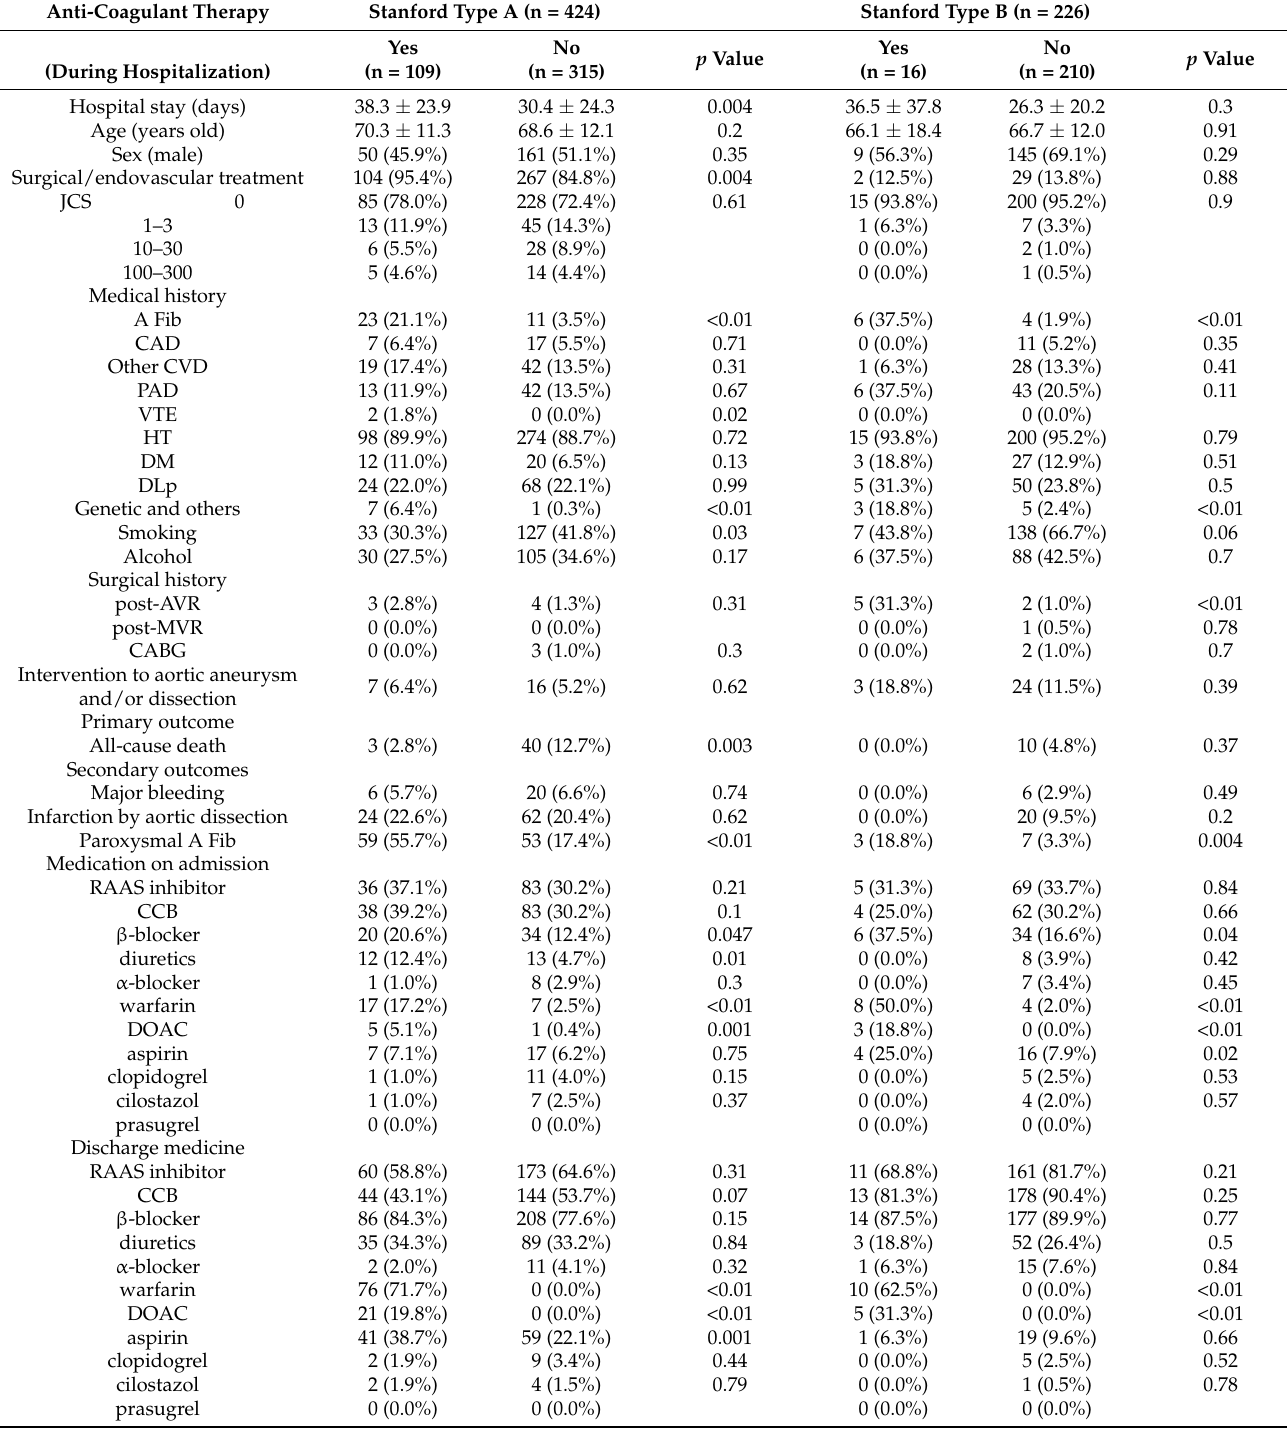
Table 7. Clinical characteristics of HOSPITALIZED acute aortic dissection with and without anti- coagulant